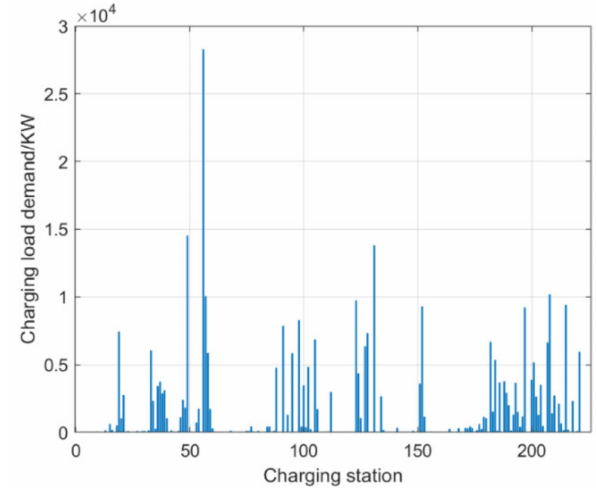
Figure 22. Charging demand of 225 charging stations.